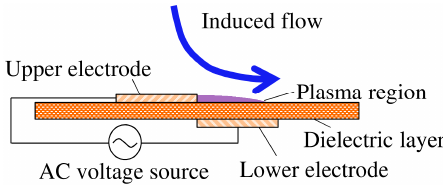
Figure 2. Typical configuration of a dielectric-barrier-discharge plasma actuator.